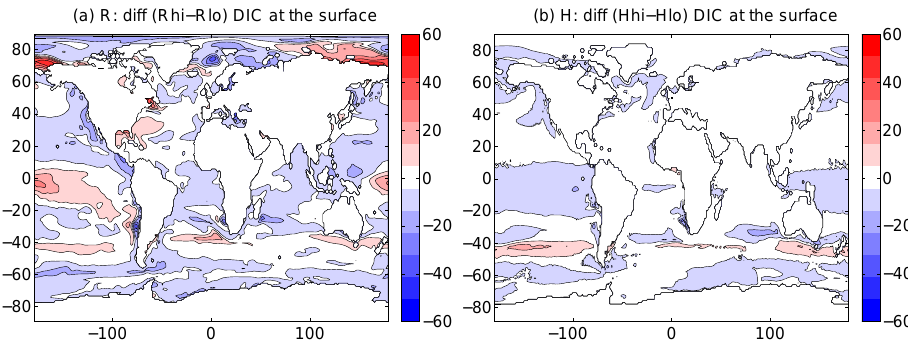
Fig. 11. DIC differences between the high and low remineralization runs in (a) GISSER and (b) GISSEH. Units are mmol C/m 3 .